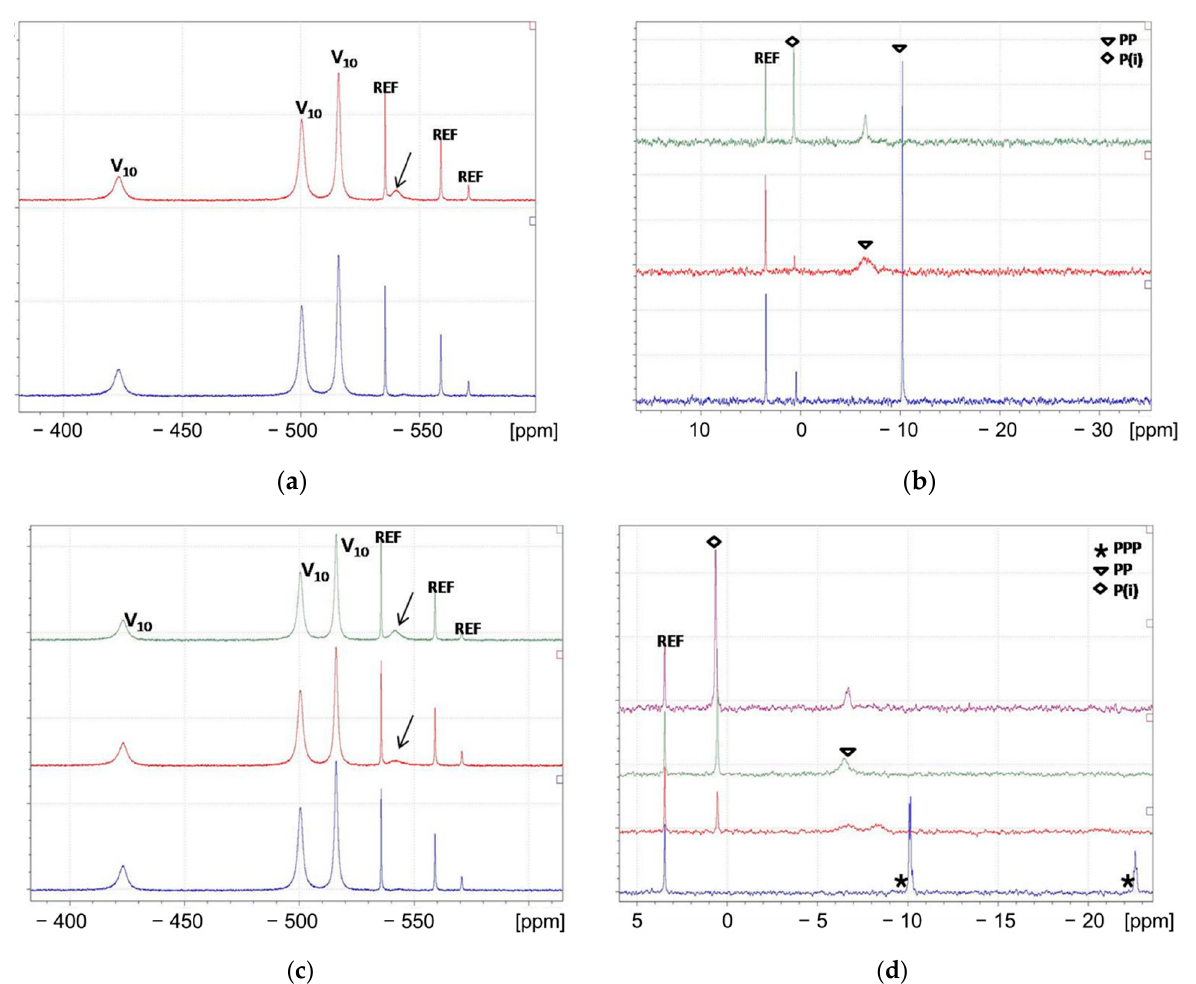
Figure 7. 51 V ‐ NMR ( left ) and 31 P ‐ NMR spectra ( right ) recorded before (blue) and immediately after mixing (red) and after 2 days (green) of ( a ) 20 mM PP and ( b ) 20 mM PPP in the presence of Na 3 VO 4 (200 mM) and NaCl (600 mM) at pH 4.0 and 25 °C. The arrow indicates the new resonance observed at − 540 ppm (see text for discussion). A small amount of phosphate was already present as impurity in the starting product PP. The sharp resonances assigned with ‘REF’ belong to the exter ‐ nal reference.